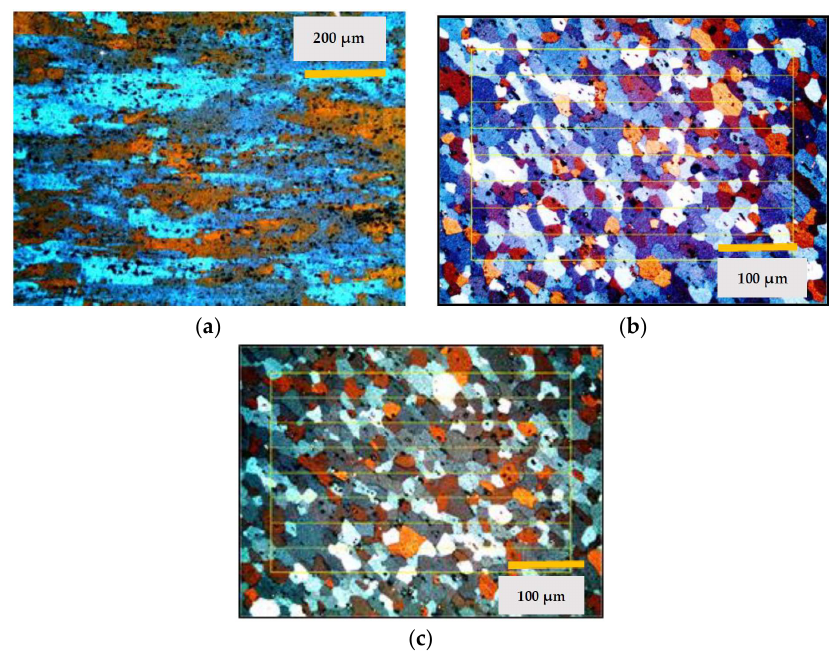
Figure 2. Metallographic images of EN-AW 5251, ( a ) microstructure in the supply state; ( b ) microstructure after thermal cycle 1; ( c ) microstructure after thermal cycle 2.